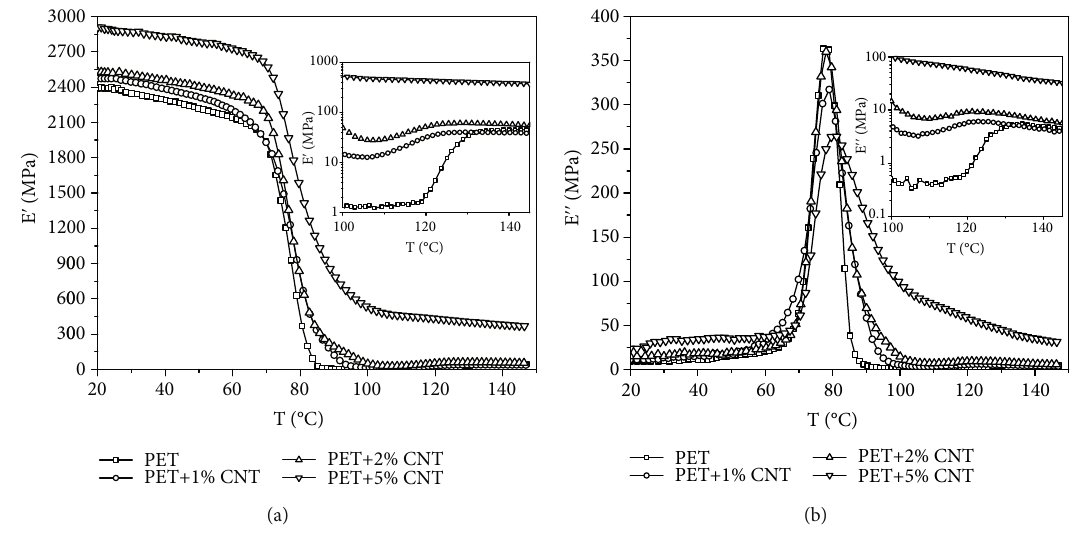
Figure 2: PET/CNT nanocomposite storage modulus E ′ (a) and loss modulus E ″ (b) depending on the temperature.